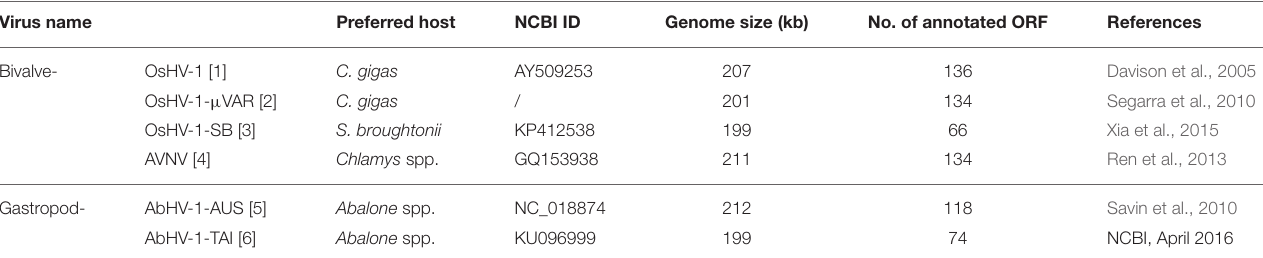
TABLE 1 | Malacoherpesviridae